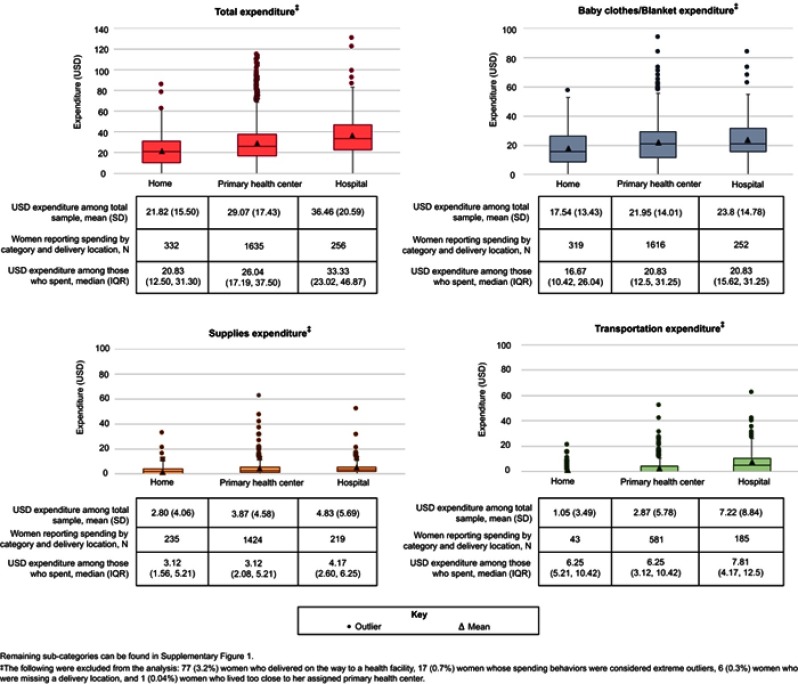
Distribution of expenditure by delivery location for total expenditure and top three sub-categories.